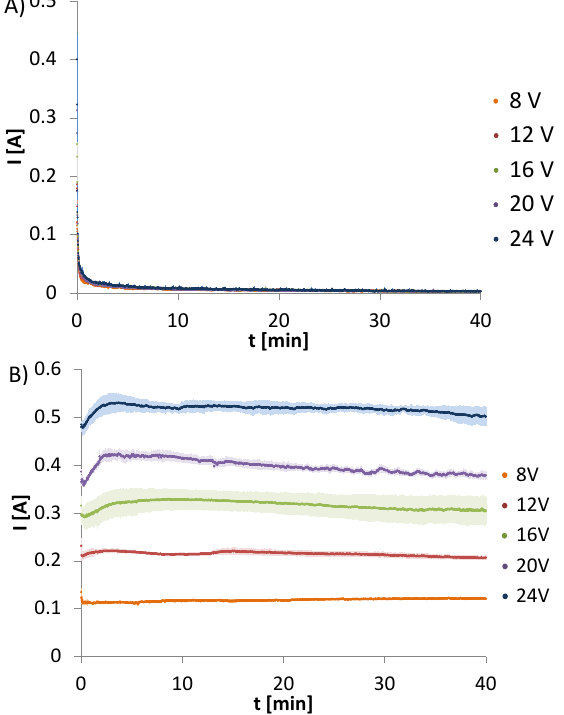
Figure 1. Amperage changes over time for electrodeposition from ( A ) chitosan and ( B ) hydroxyapatite colloidal solutions initiated at different voltages. Data are shown as a mean ± standard deviation (n = 3).